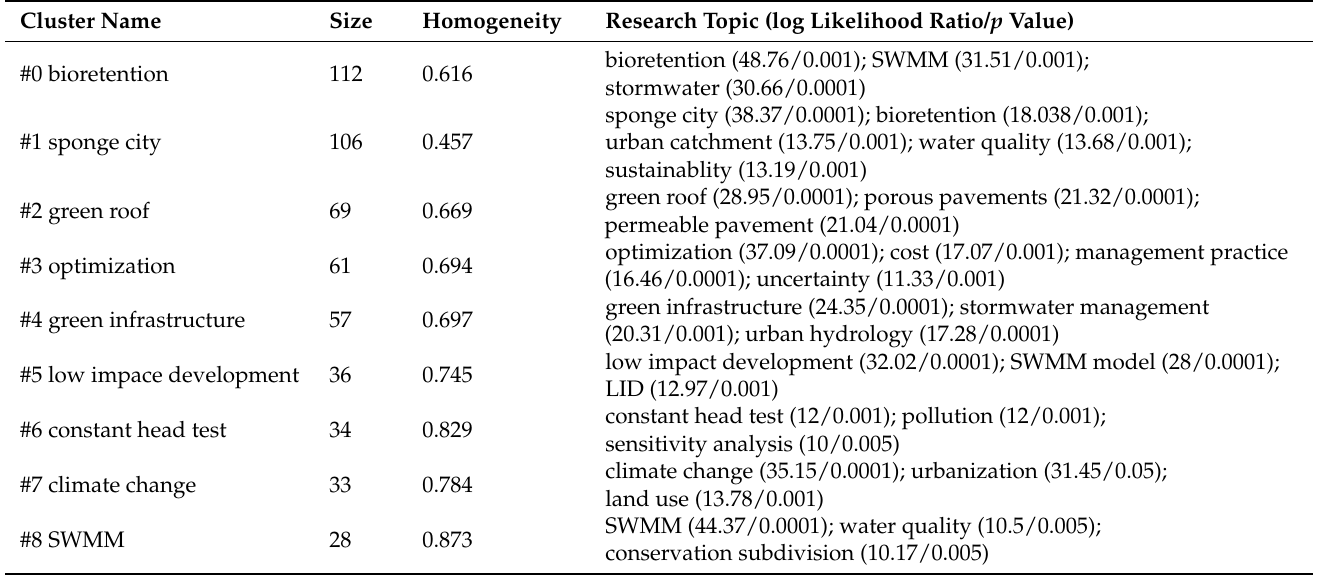
Table 5. The keyword clustering of the publications based on the WOS